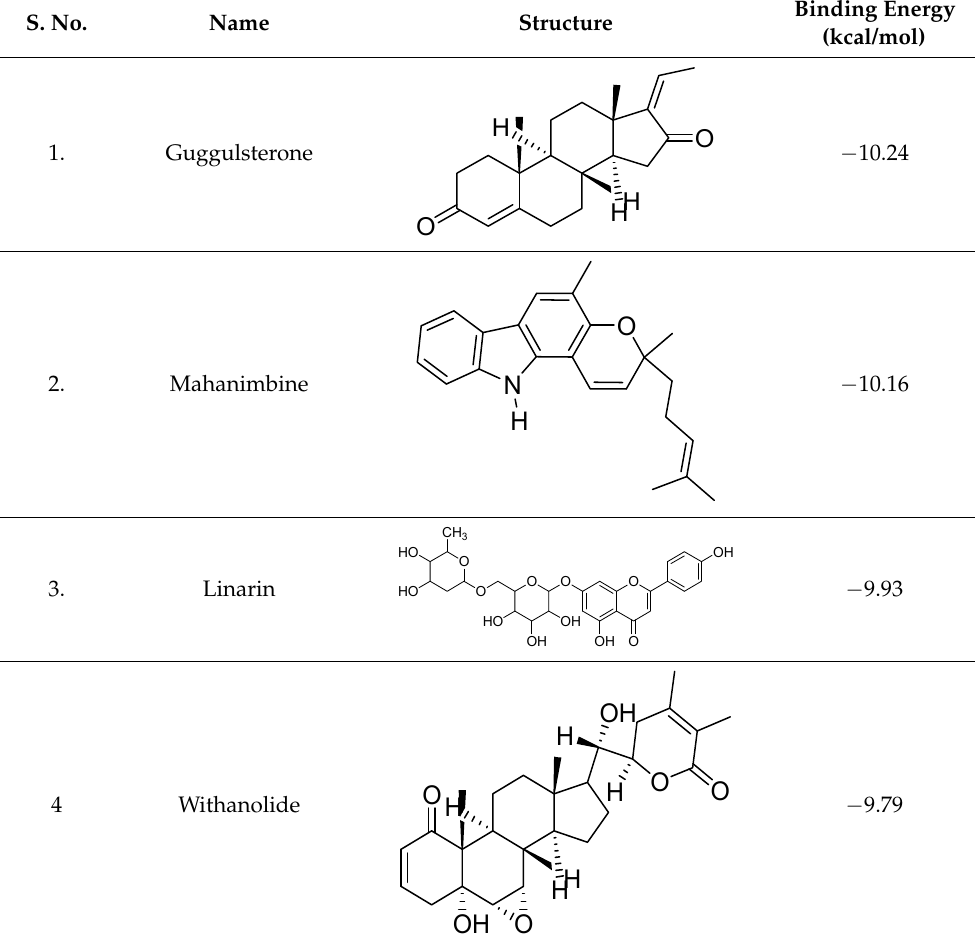
Table 3. The binding energies of shortlisted herbal leads to the viral ARP enzyme. S.